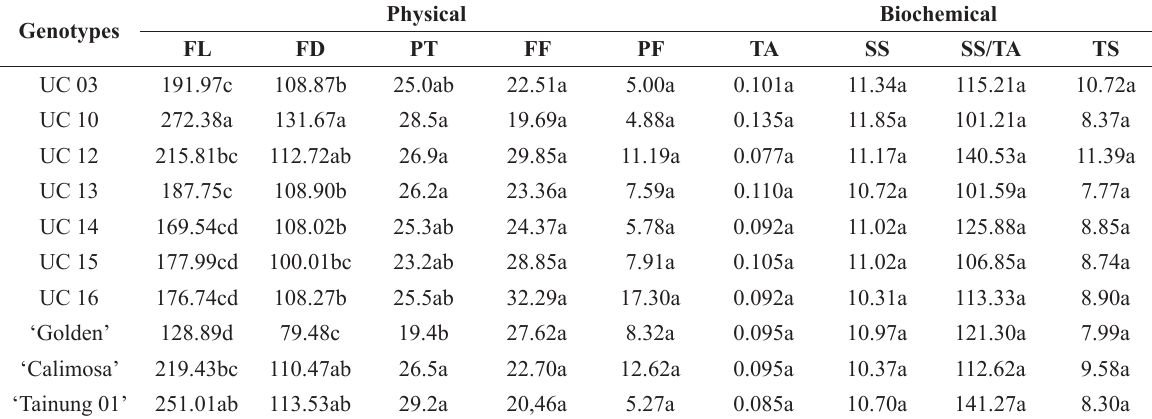
Averages of the fruit qualitative